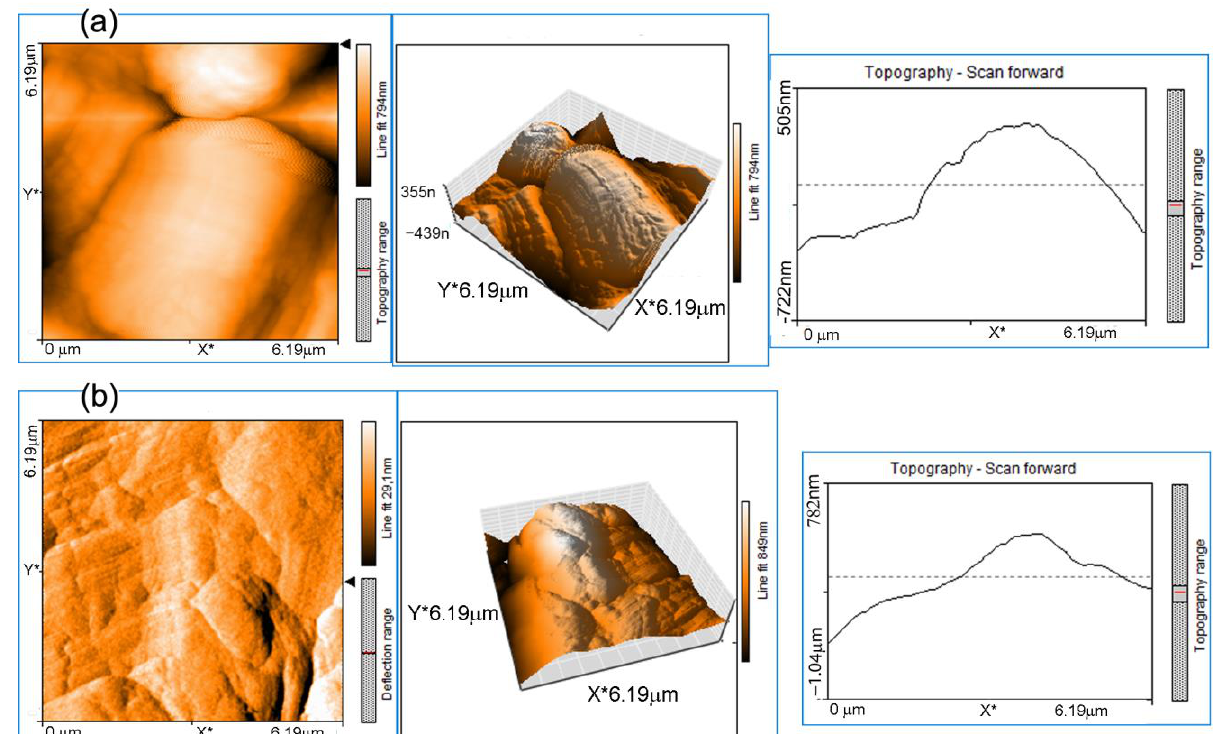
Figure 4. AFM scans of the surface of the ceramic layers ( a ) before and ( b ) after thermal